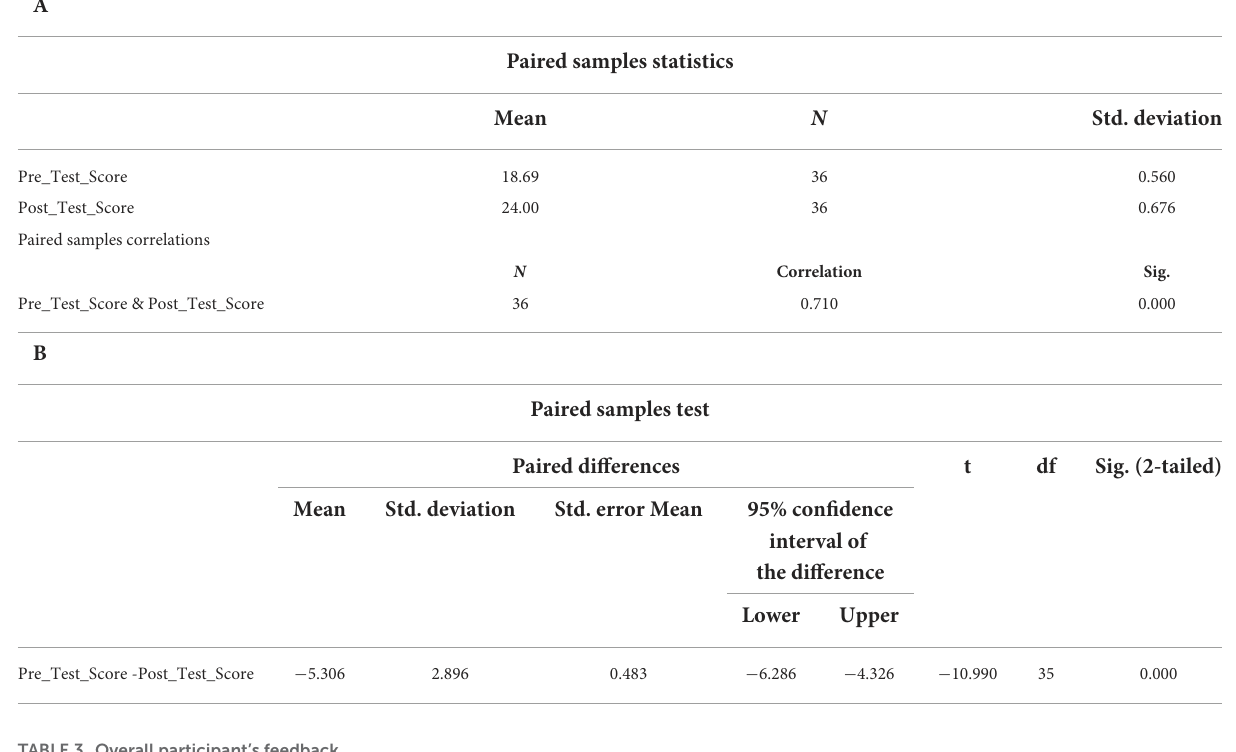
TABLE 2 Pre-test and post-test score evaluation.